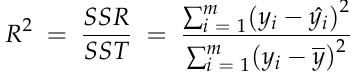
Figure 18. A visual curve with an explicit elbow point in the K range [1; 10].